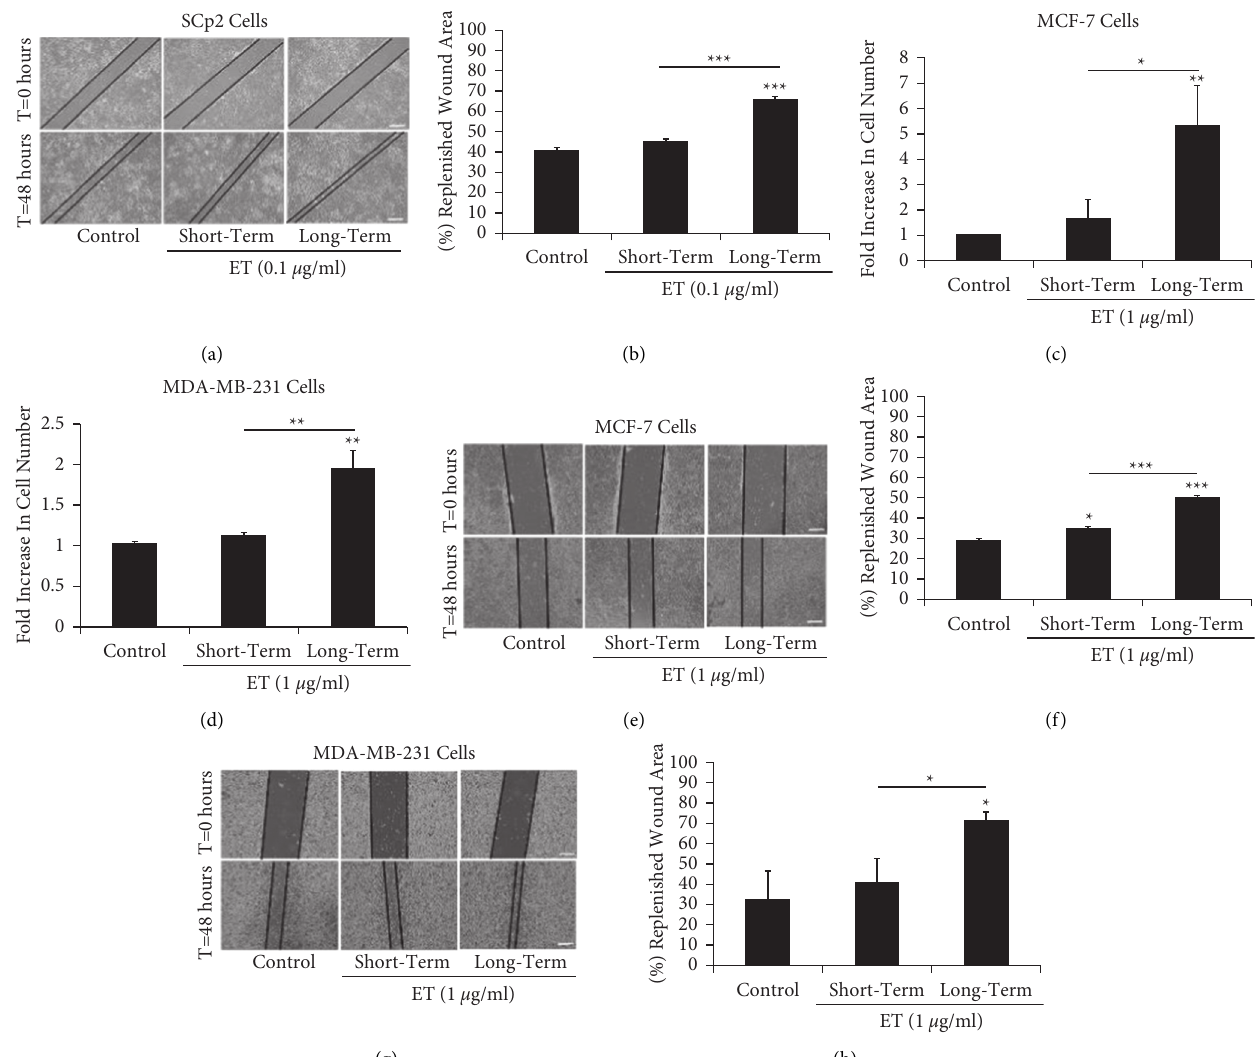
Figure 3: Long-term endotoxin treatment enhances migration of normal mouse mammary epithelial cells (SCp2) and human breast cancer cells (MCF-7 and MDA-MB-231). (a) Wound healing assay showed enhanced replenishment of wound area with migrating SCp2 cells upon long-term exposure (for one month) to 0.1 µ g/ml ET, as opposed to short-term exposure (for 48 hours after wounding) or untreated controls (0 µ g/ml). (b) Bar graph shows the percentage of the replenished wound area with migrating SCp2 cells upon short-term and long-term exposure to 0.1 µ g/ml ET relative to untreated controls, for 48 hours after wounding. (c) Long-term exposure to 1 µ g/ml ET increased the proliferation rate of MCF-7 and (d) MDA-MB-231 cells, as opposed to short-term exposure, where the increase in cell count was not significant when compared to untreated controls (0 µ g/ml). Wound healing assay showed enhanced migration of (e, f) MCF-7 upon short (albeit marginal) and long-term exposures and (g, h) MDA-MB-231 upon long-term exposure to 1 µ g/ml ET, when compared to untreated controls (0 µ g/ml). Scale bar � 100 µ m. Each bar represents triplicate analyses of mean ± SD. ∗ P < 0 . 05; ∗∗ P < 0 . 01; ∗∗∗ P < 0 . 001 compared to the untreated